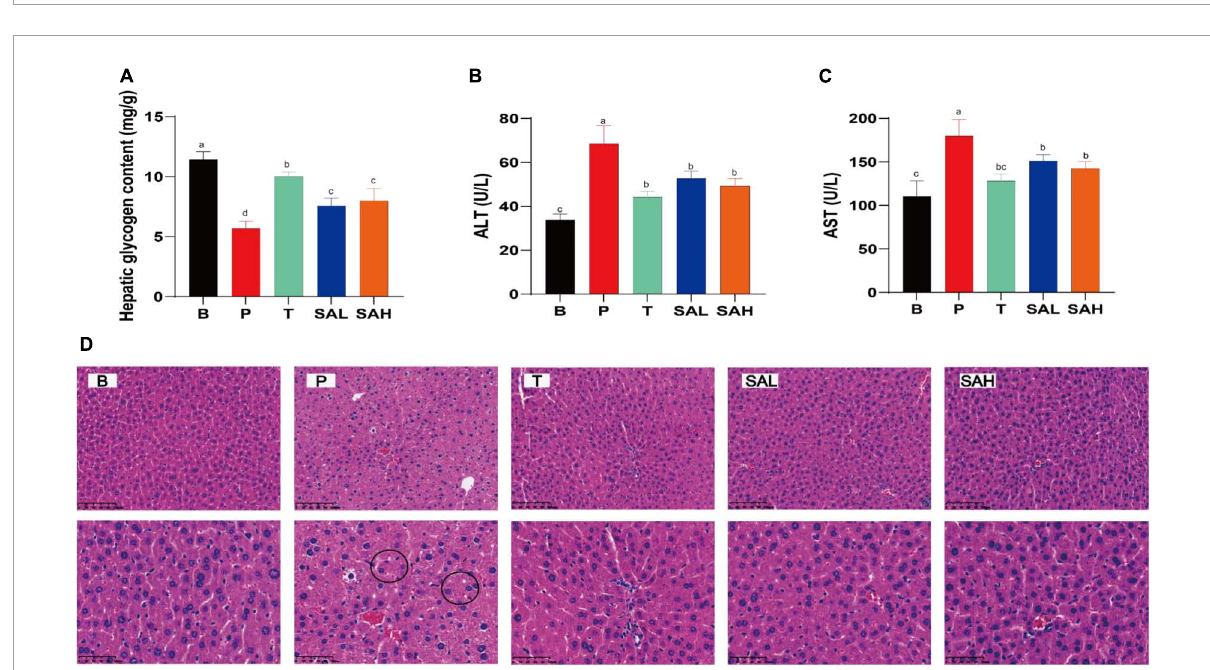
FIGURE3 Sciadonic acid (SA) ameliorates hepatic impairment in type 2 diabetes mellitus (T2DM) mice. (A) Hepatic glycogen content, (B) ALT, (C) AST, and (D) H&E stain. Data are presented as the mean ± SD of three experiments. Different letters represent a significant difference among multiple groups ( P < 0.05). B, control group; P, diabetic model group; T, (HFD + 200 mg kg – 1 Met); SAL, (HFD + 70 mg kg – 1 SA); SAH, (HFD + 280 mg kg – 1